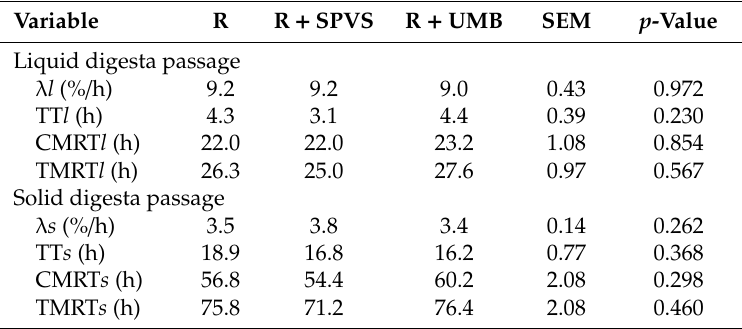
Table 3. Parameters of liquid ( l ) and solid ( s ) digesta passage in heifers fed roughage (R) 1 alone